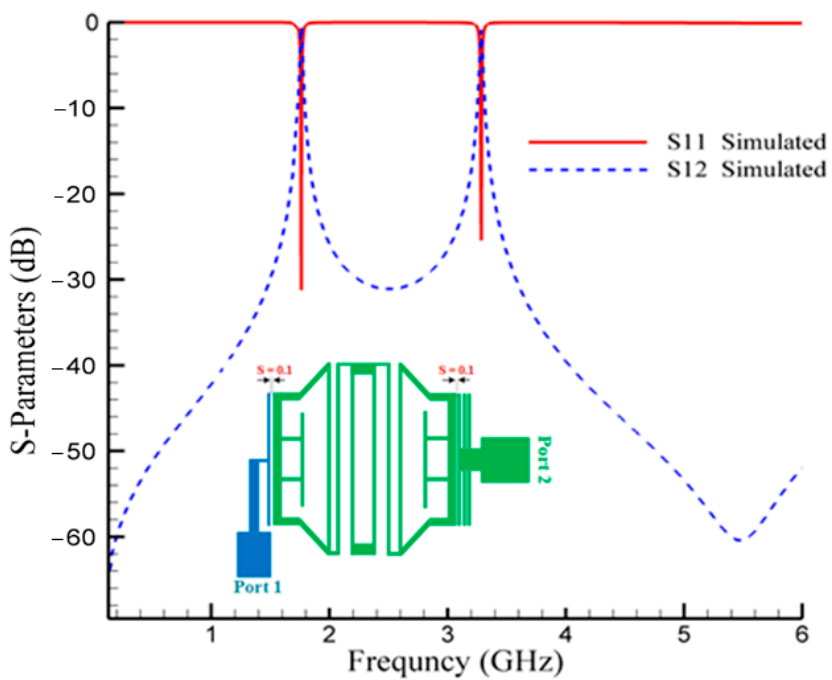
Figure 8. Simulated frequency responses of the second proposed BPF at 1.7/3.3 GHz.